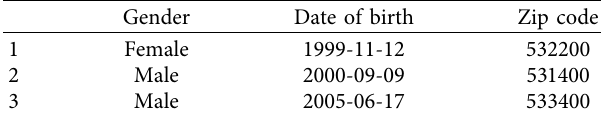
Table 2: Results after